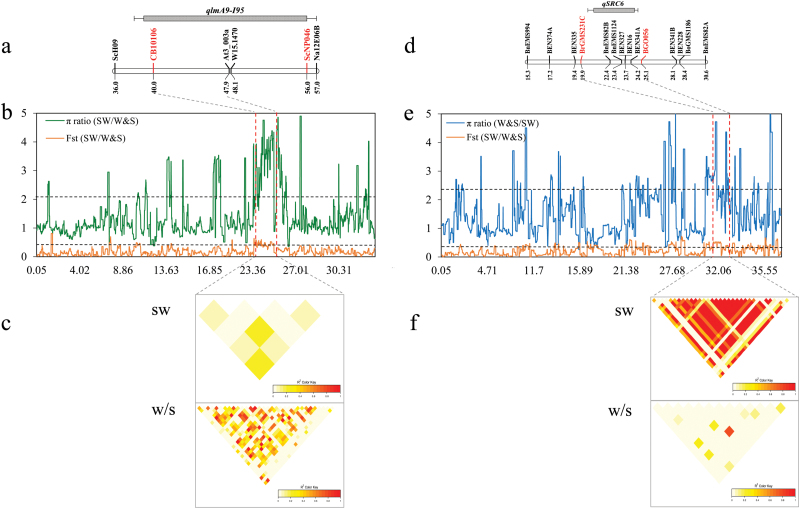
Selective sweep for the blackleg resistance quantitative trait loci (QTLs) on chromosome A09 and the Sclerotinia resistance QTLs on chromosome C06. (a and d) Map positions of the blackleg resistance QTL qLmA9-I95 (Delourme et al., 2008) and the Sclerotinia resistance QTL qSRC6 (Wu et al., 2013). (b and e) Empirical π ratio and FST distributions within the QTL region; the black dotted line indicates the threshold value of the top 5% π ratio and FST. (c and f) Linkage disequilibrium pattern of 196 semi-winter (SW) and 131 winter/spring (W/S) ecotypes in the region of the selective sweep; the color key indicates the r2 values.